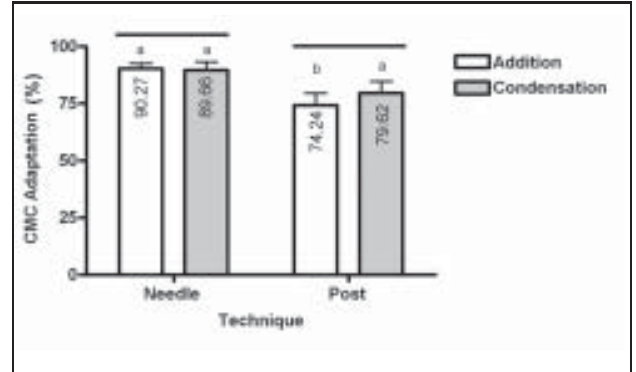
(p<0.05).Figure 2. Data from radiographic analysis. Percentage of the root canal occupied by the CMC with the intracanal impression techniques (hypodermic needle or polycarbonate post) using either addition or condensation silicone. Horizontal lines above the columns indicate results without statistical significance (p>0.05). Different letters comparing the same material indicate statistically significant difference